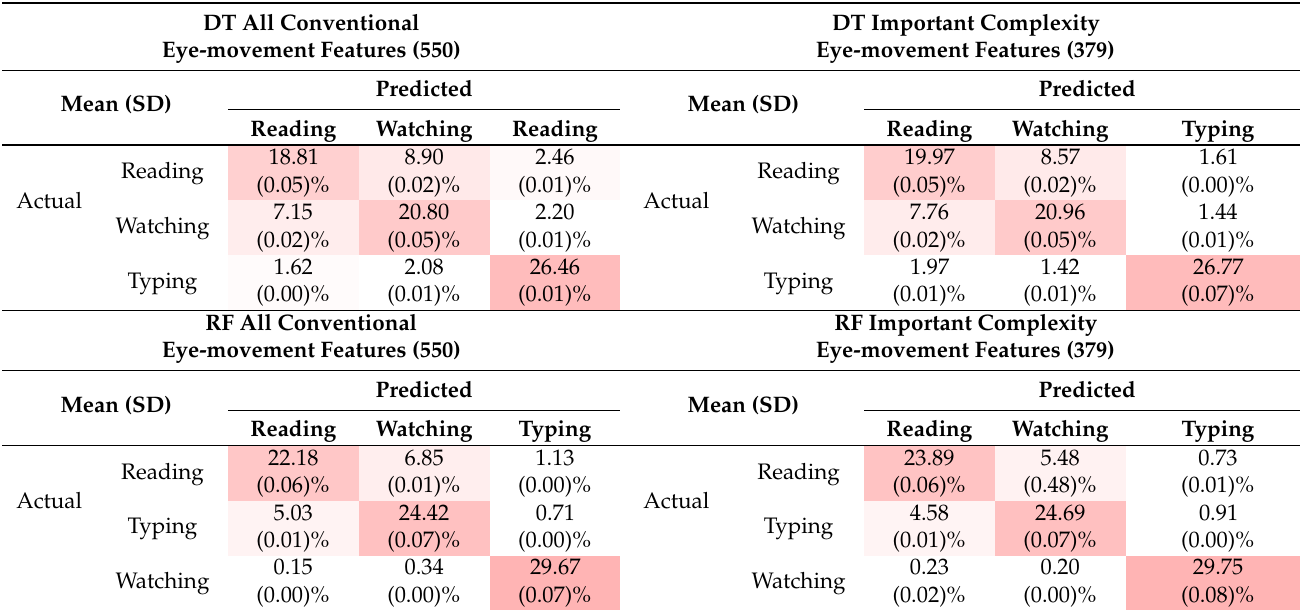
Figure 4. Accuracy comparison of 6 types of ML models built using eye-movement complexity features. The number of used features for building the models is indicated by numbers in parentheses. Means that do not share a letter are significantly different. Table 5. Confusion matrices of the DT and RF Models were built both using all-important complex- ity features.